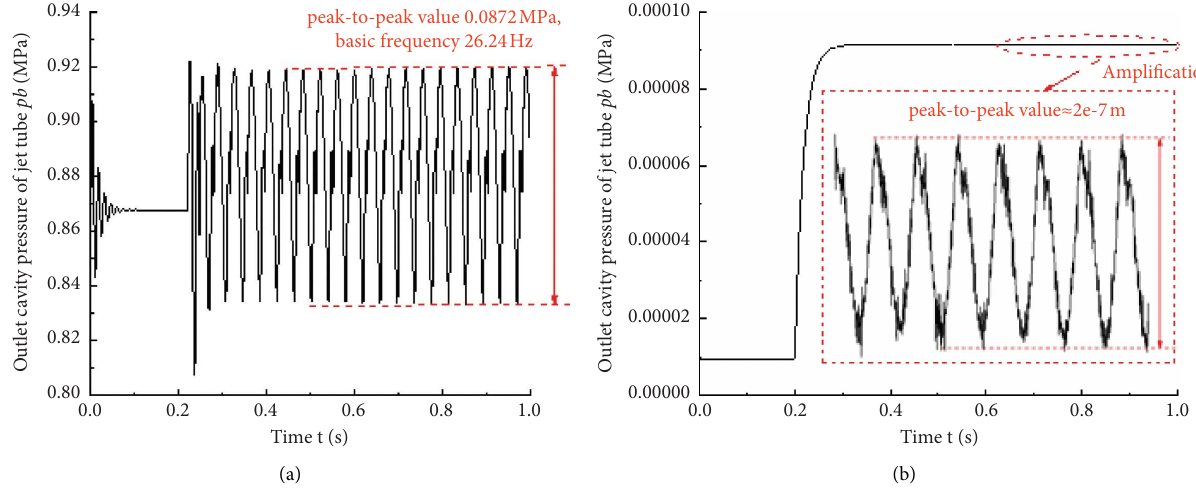
Figure 6: Matlab/Simulink simulation results. (a) Outlet chamber pressure of the jet pipe. (b) Feedback valve core displacement.